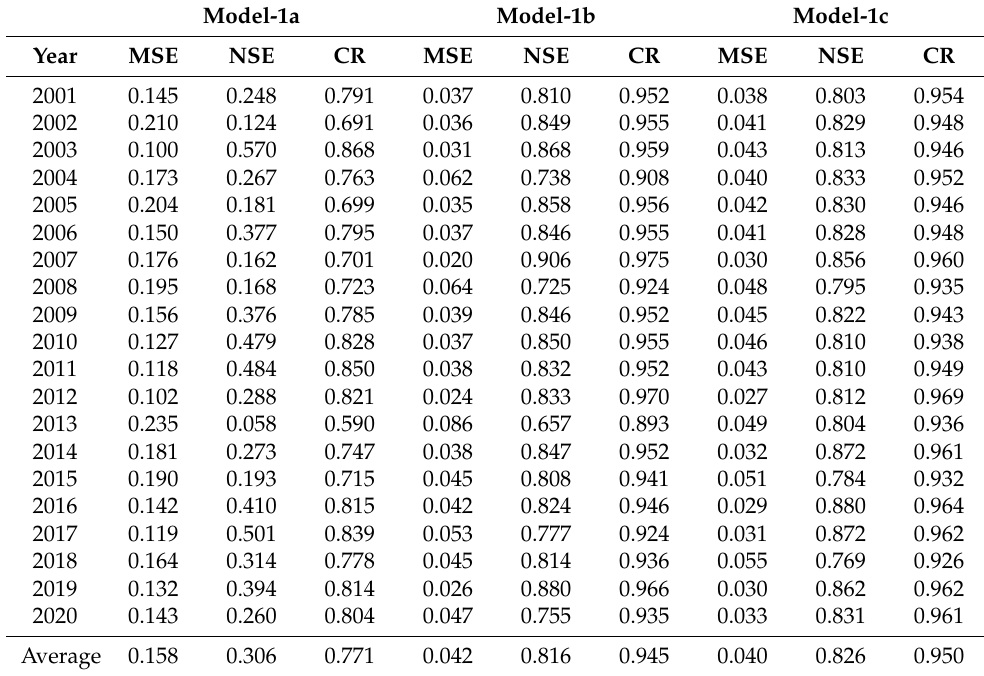
Table A2. Model evaluation scores: The mean squared errors (MSEs), Nash–Sutcliffe model efficiency coefficients (NSEs), and the correct classification rates (CRs) for the Model-1 class based on their estimates at t = 2001, . . . , 2020. The last row gives the time-averaged model evaluation